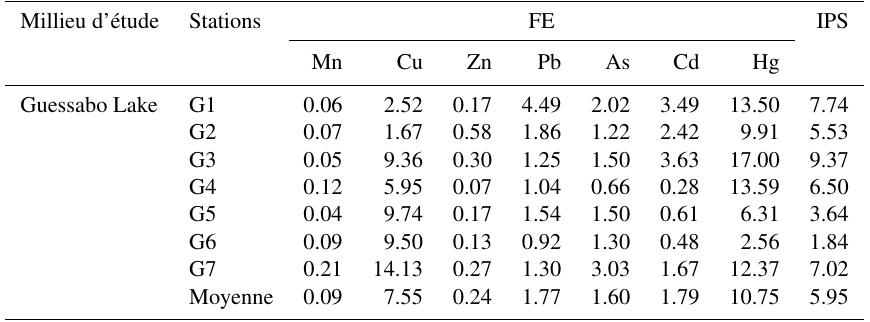
Tableau 2. Récapitulatif des valeurs moyennes du facteur d’enrichissement et de l’indice de pollution sédimentaire par station et par élément métallique dans les sédiments du lac Guessabo.